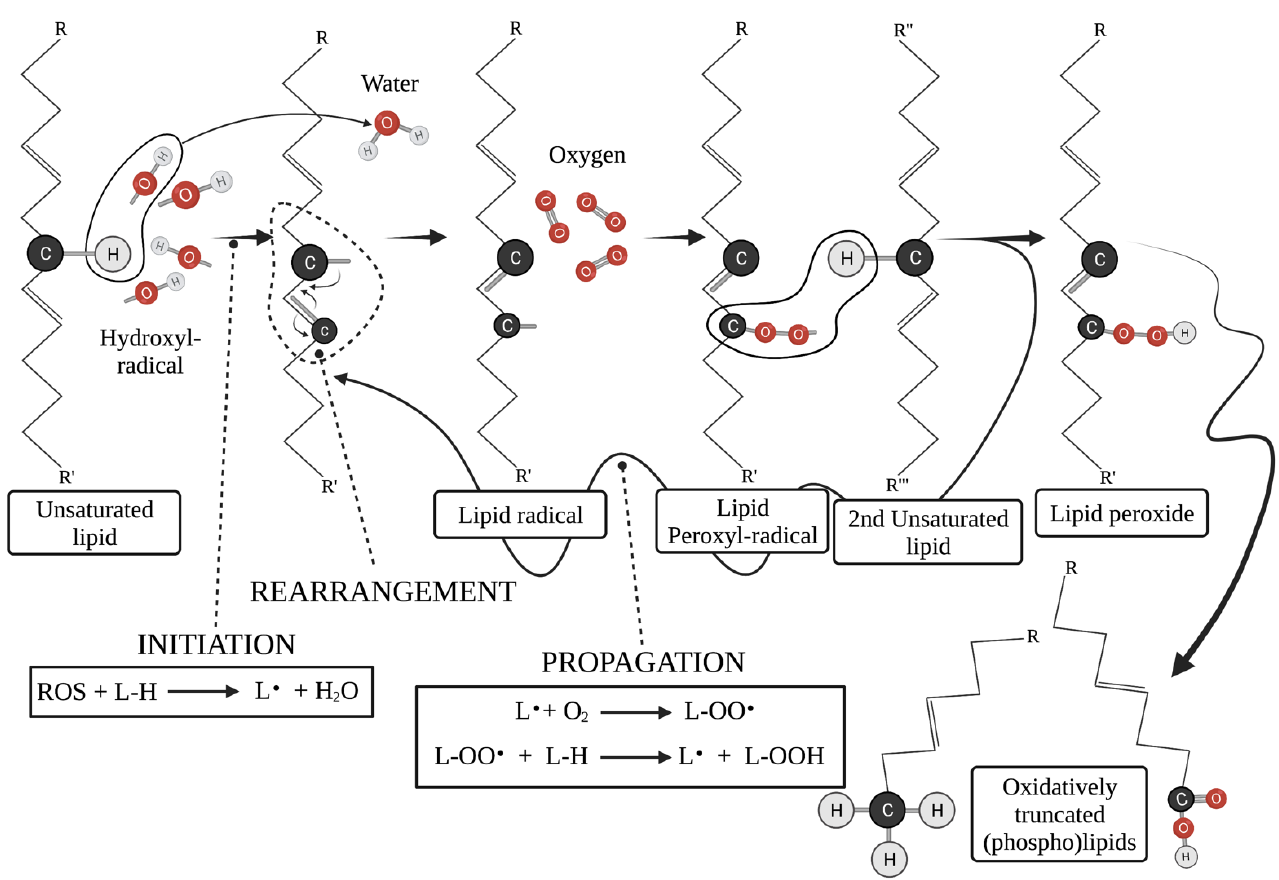
Figure 2. Schematic presentation of the lipid peroxidation reaction. INITIATION: During this first step of lipid peroxidation, an initiator being for instance an ROS (in this paradigm a hydroxyl radical (OH - )) attacks an unsaturated bond of a Lipid (L) acyl chain. From this reaction, a lipid radical is formed along with water (H 2 O). REARRANGEMENT: During this step, a random reorganization of electrons occurs, giving rise to a new lipid radical (L . ). NOTE: This step may or may not occur. PROPAGATION : During this step of lipid peroxidation, the lipid radical, rearranged or not, reacts with molecular oxygen (O 2 ), forming a lipid peroxyl radical (L-OO . ). The peroxyl radical then abstracts a proton from a bystander lipid, forming a novel lipid radical that reenters the reaction and a lipid peroxide (L-OOH). The lipid peroxide may thereafter be remodeled into oxidatively truncated phospholipids [23]. Due to their different size, oxidatively truncated lipids have different properties than their precursors. Lipid peroxidation and oxidative truncation also happens on the acyl chains of membrane phospholipids. The subsequent altered scheme distorts membrane integrity with variable effects for the cell. In the case of mitochondria, such consequences are analyzed in detail. C: Carbon, H: hydrogen, O: oxygen (atomic), R- R’ - R’’ -R ’’’ : acyl chain side groups. Created with BioRender.com, accessed on 20 March